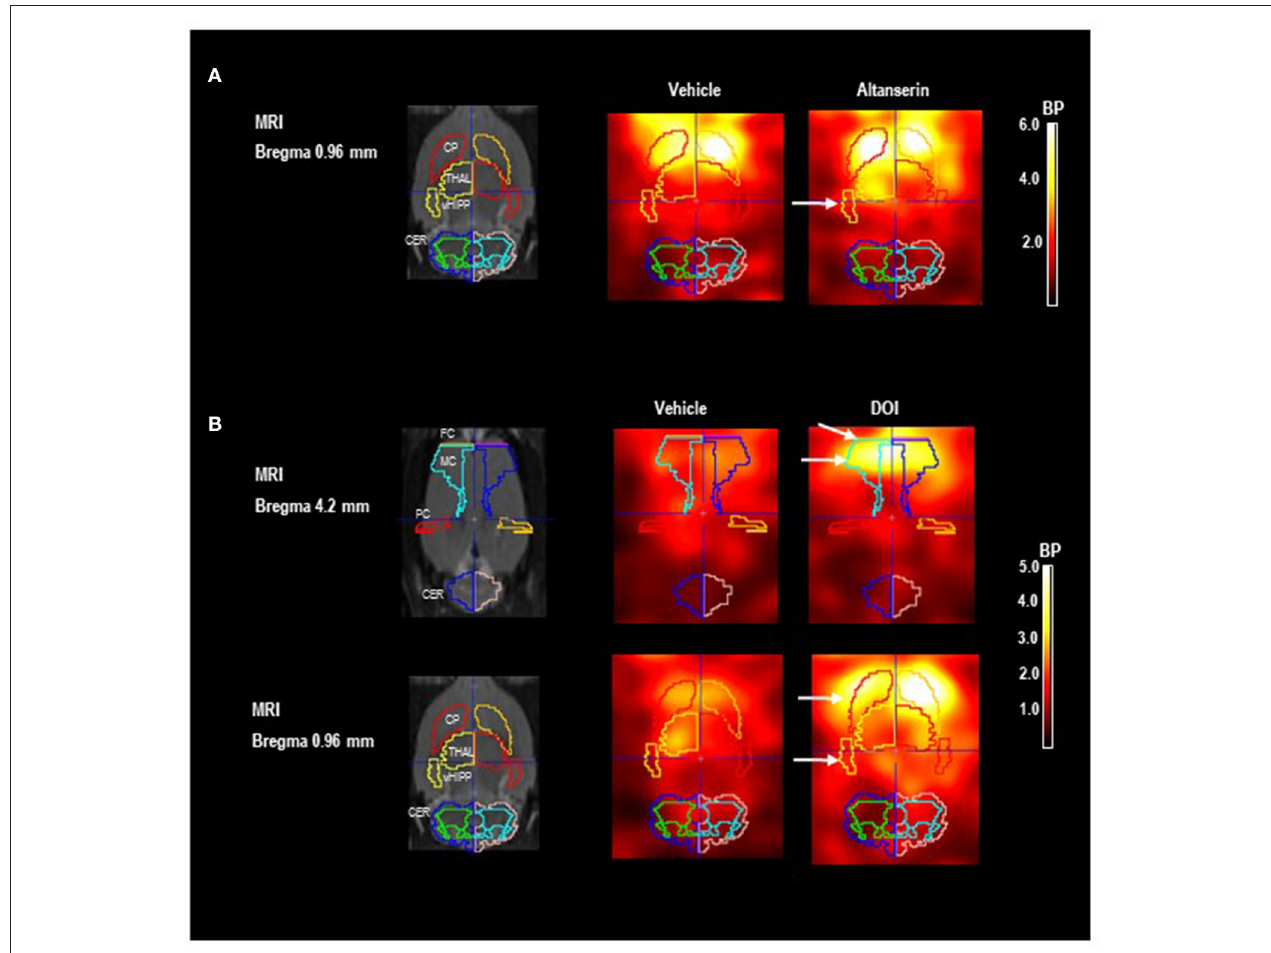
FIGURE 2 | Paxinos standard rat brain MRI and D 2 / 3 R single-photon emission computed tomography (SPECT) images after 5-HT 2A receptor antagonistic (A) and agonistic treatment (B) with [ 123 I]IBZM as a radioligand. The left column shows Paxinos standard rat brain MR images ( Schiffer et al., 2006) at different positions from bregma together with the standard volume of interest (VOI) templates provided by PMOD. The middle column shows coronal SPECT slices in two characteristic rats after pretreatment with (A) dimethyl sulfoxide (DMSO) and (B) saline as vehicle at the same positions from bregma depicted in the left column. The right column shows SPECT slices in the same rats after pretreatment with (A) 10 mg/kg of altanserin and (B) 0.5 mg/kg of 2,5-dimethoxy-4-iodoamphetamine (DOI) at the same positions from bregma. Increases of [ 123 I]IBZM accumulation are marked by white arrows. SPECT images show binding potentials (BPs). It is understood that the calculation of BPs is only valid for regions with specific radioligand binding. Analysis and image algebra were performed with PMOD (version 3.5, PMOD Technologies Ltd., Zürich, Switzerland). CER, cerebellum; CP, caudate putamen; FC, frontal cortex; MC, motor cortex; PC, parietal cortex; THAL, thalamus; vHIPP, ventral